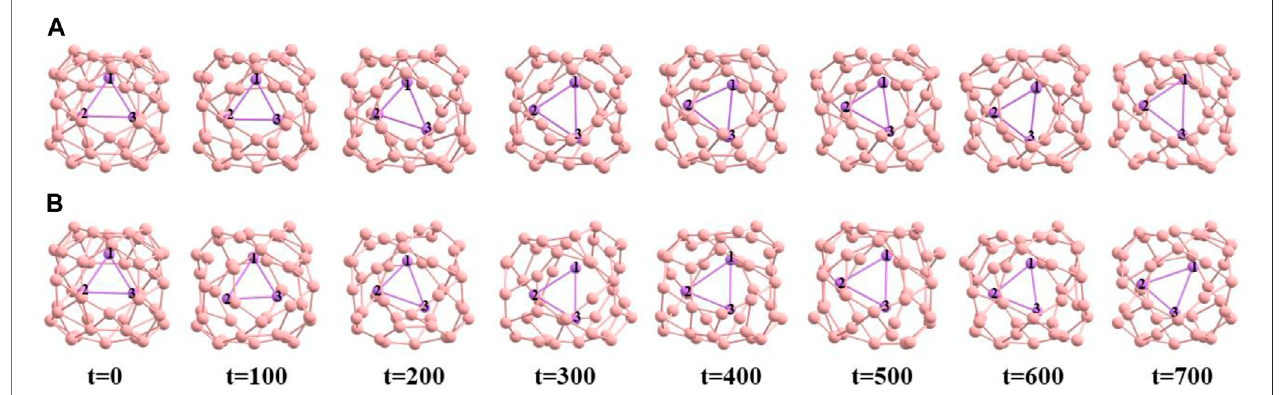
FIGURE 4 | Snapshots at different time steps (time in fs) (A) at 300 K temperature, (B) at 500 K temperature of Li 3 @B 40 system.